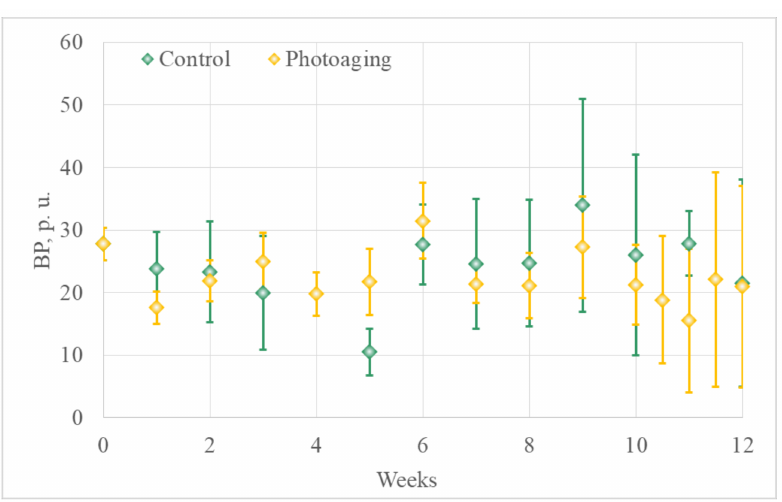
Figure A5. Dynamics of mean values of baseline perfusion (BP) in animal groups measured in perfusion units (p.u.). Standard deviations are